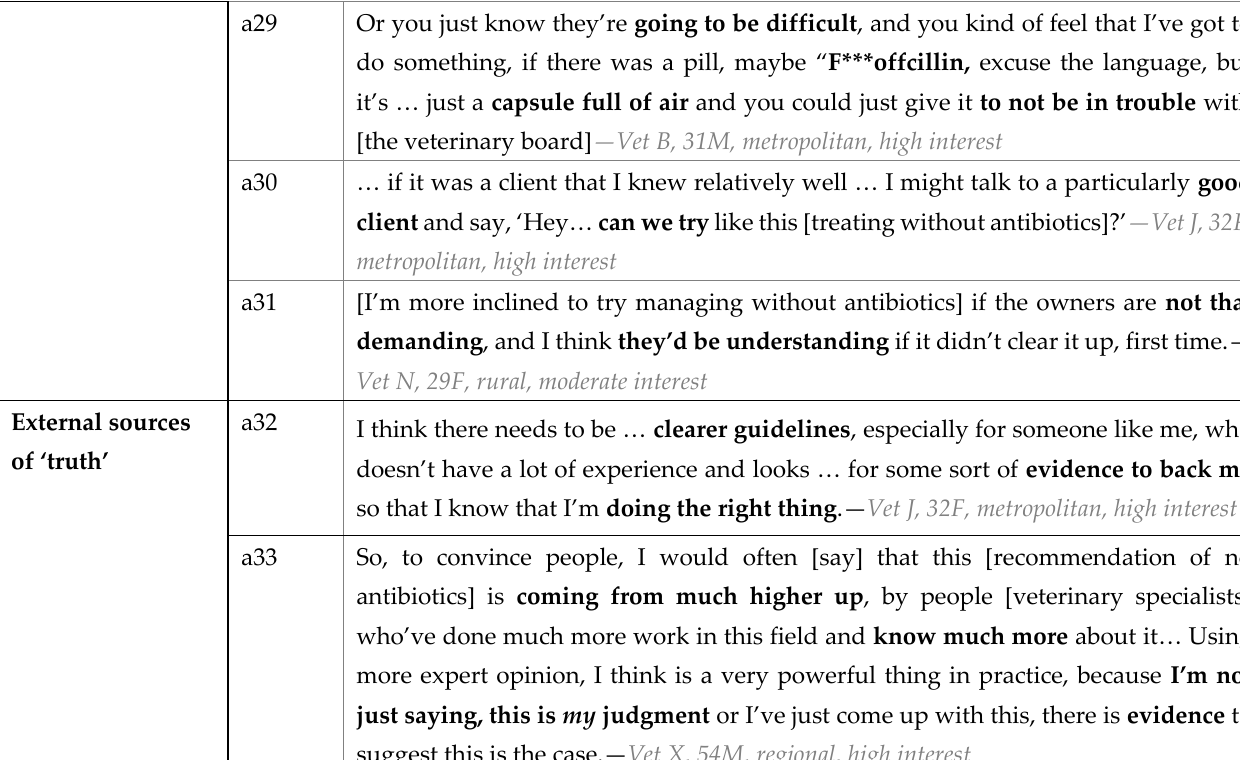
Figure 3. Background factors influencing the decision to withhold or delay antimicrobial treatment where there was no clear indication, and illustrative quotes. Bold text has been used to highlight key ideas. Grey italics have been used for participant code, age and gender, location of practice and level of interest in AMR and AMS. *** represents redacted obscenity.